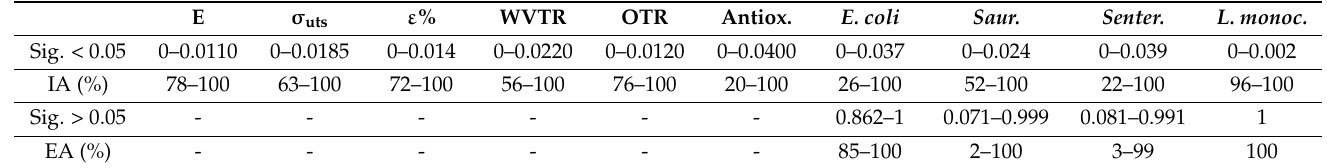
Table 5. Significance level, equality, and inequality, assurance of mean values for Young Modulus